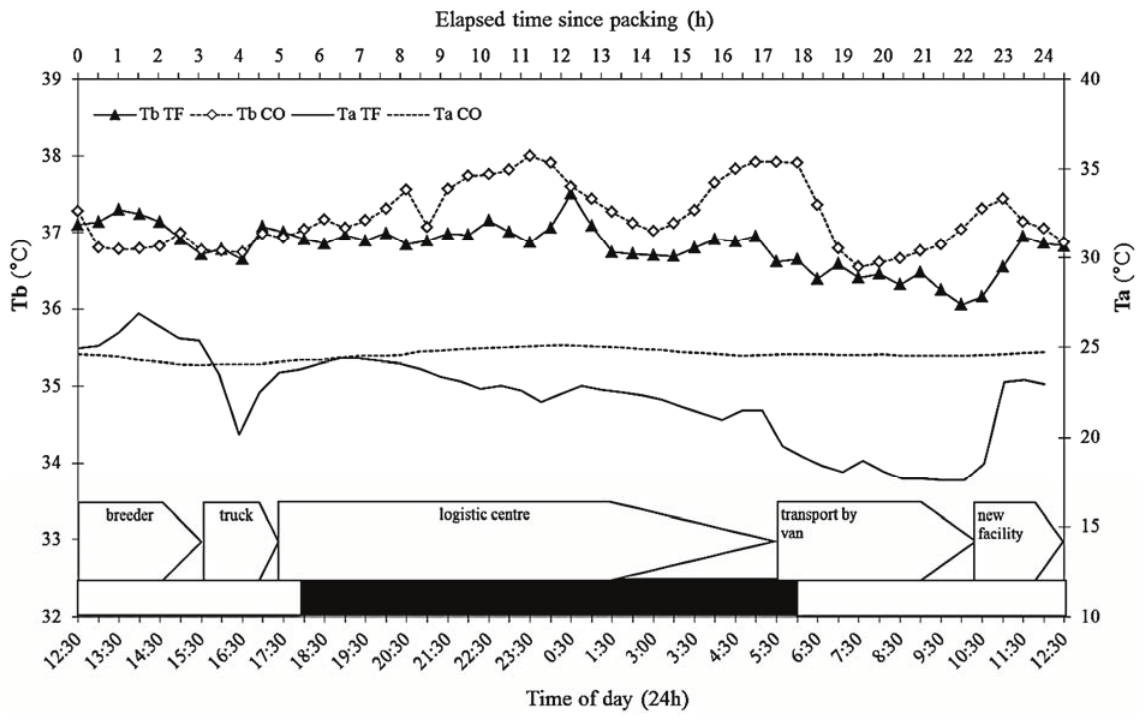
Figure 3. Core body temperature T b of transferred (triangles) and control (diamonds) rats and ambient temperature T a inside transportation boxes (solid line) (°C ± SD) during transfer and in control area (dotted line) (top x-axis: time since packing, bottom x-axis: actual time). The black-white bar at bottom indicates light (white) and dark (black) periods. Different stages during transfer are included. n = 16, sexes